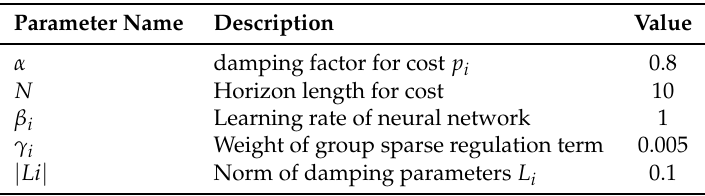
Table 3. Parameter of controller in IEEE 24 bus test system.